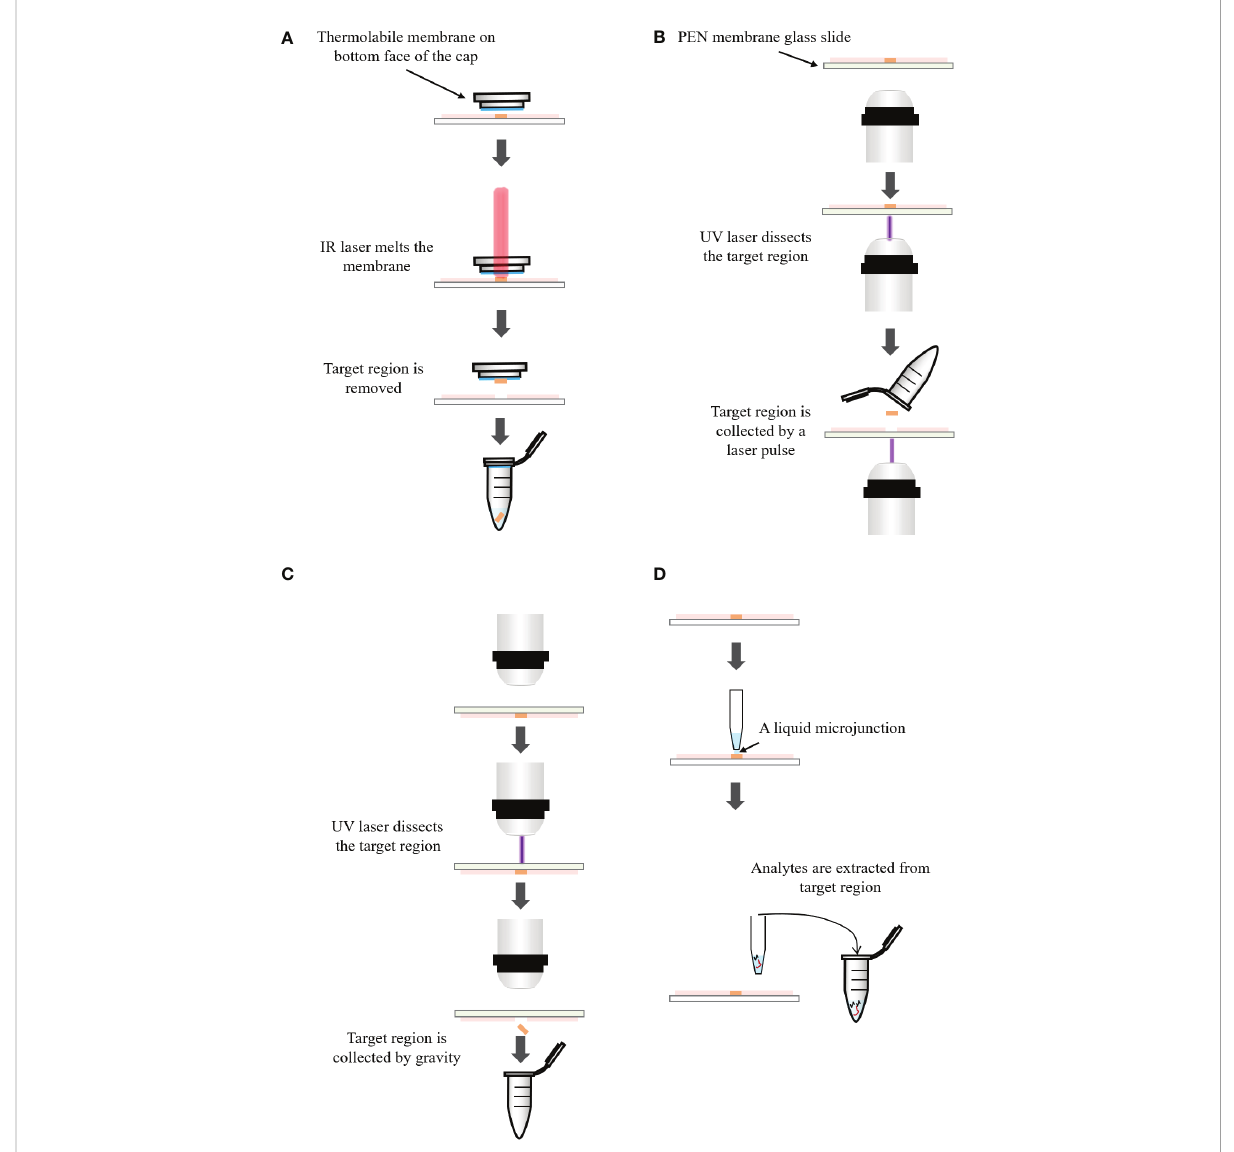
FIGURE 3 (A) Principle of the Arcturus laser capture microdissection. A thermolabile membrane on bottom face of the cap is placed on the tissue section. The infrared (IR) laser activates the membrane which extends to the tissue. The adhesion force of the tissue to the activated membrane exceeds that to the glass slide. The selected area is removed from the tissue. (B) Principle of the Zeiss ’ s PALM microdissection. The tissue section is mounted on a polyethylene napthalate (PEN) membrane coated glass slide. After selecting the region of interest, ultraviolet (UV) laser ablates the surrounding cells and cuts away the selected area, which is then transported into a collection tube by a de fi ned laser pulse against gravity. (C) Principle of the Leica LMD microdissection. The tissue section is mounted on the PEN membrane glass slide and placed upside down on the stage. The target tissue is dissected by the laser and directly falls into a collection tube underneath the tissue section. (D) Principle of liquid microjunction extraction. The probe aspirates the extraction solvent and dispenses a portion onto the tissue surface to create a liquid microjunction between the probe and the tissue surface. After a prede fi ned extraction time, analytes that are soluble in the solvent are extracted into the liquid microjunction. The extracted solution can be analyzed by LC-MS